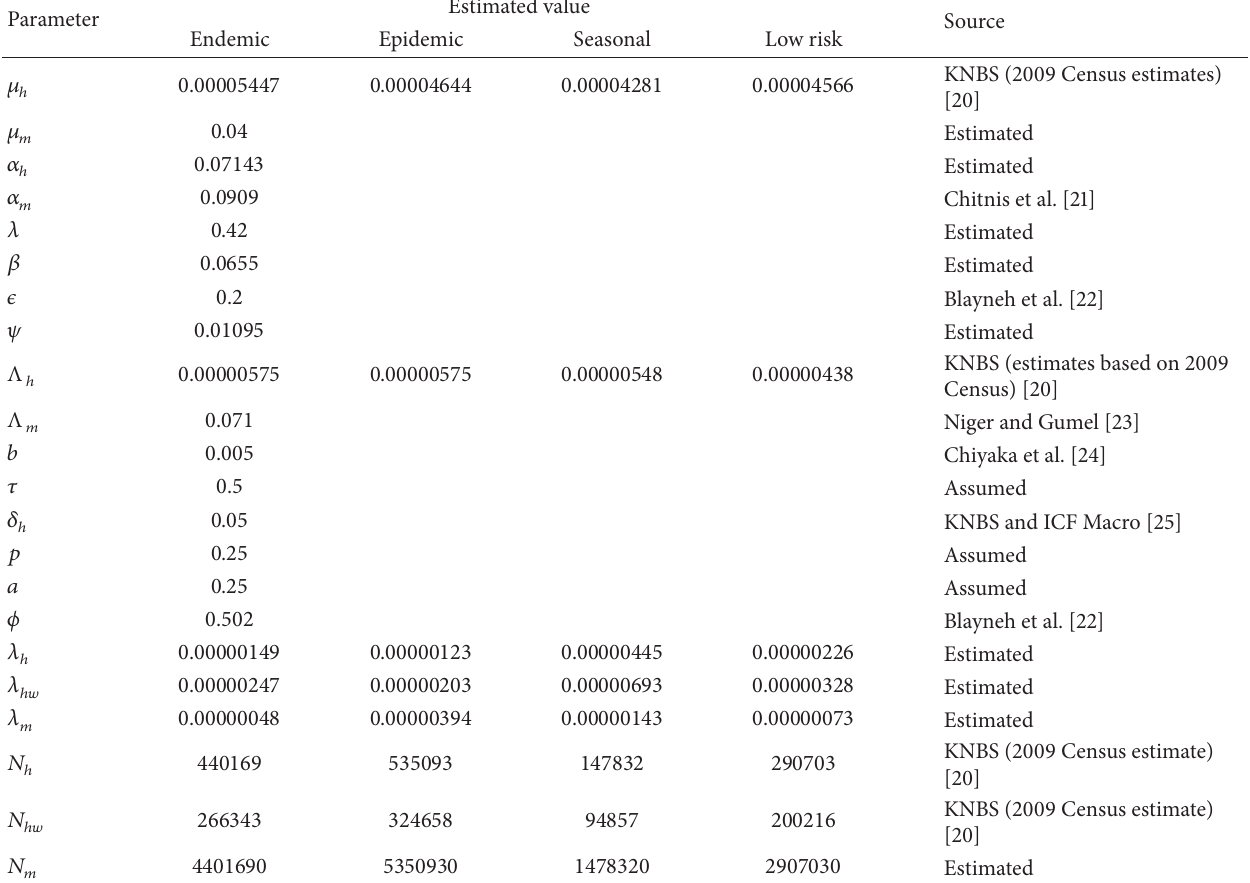
Table 5: Parameter values for the full malaria